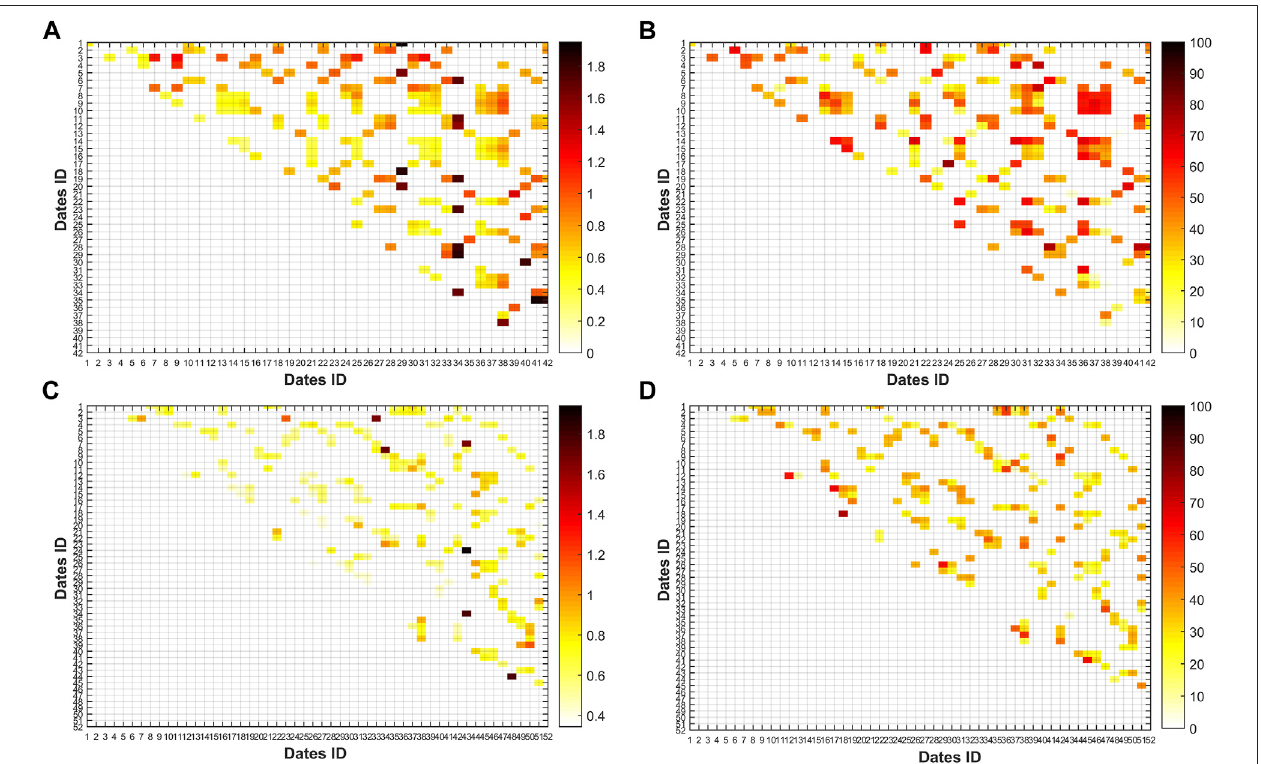
FIGURE13| Uncertaintyoftheoffsetmapsafterinversion (A) andthepercentageofimprovementintheuncertaintybeforeandafterinversion (B) fortheLandsat-8 frameP183/R48. (C) and (D) ,similarto (A,B) butfortheLandsat-8 frameP184/R48. Thecoloredcellsrepresent thepairswiththemasteronthe y -axisandslave onthe x -axis.Eachpairisde fi nedbytheacquisitiondates.Theacquisitiondatesofeachframecanbefoundin SupplementaryTablesS1,S2 .UnitsinAandCarein(m)while (B, D) are percentages.